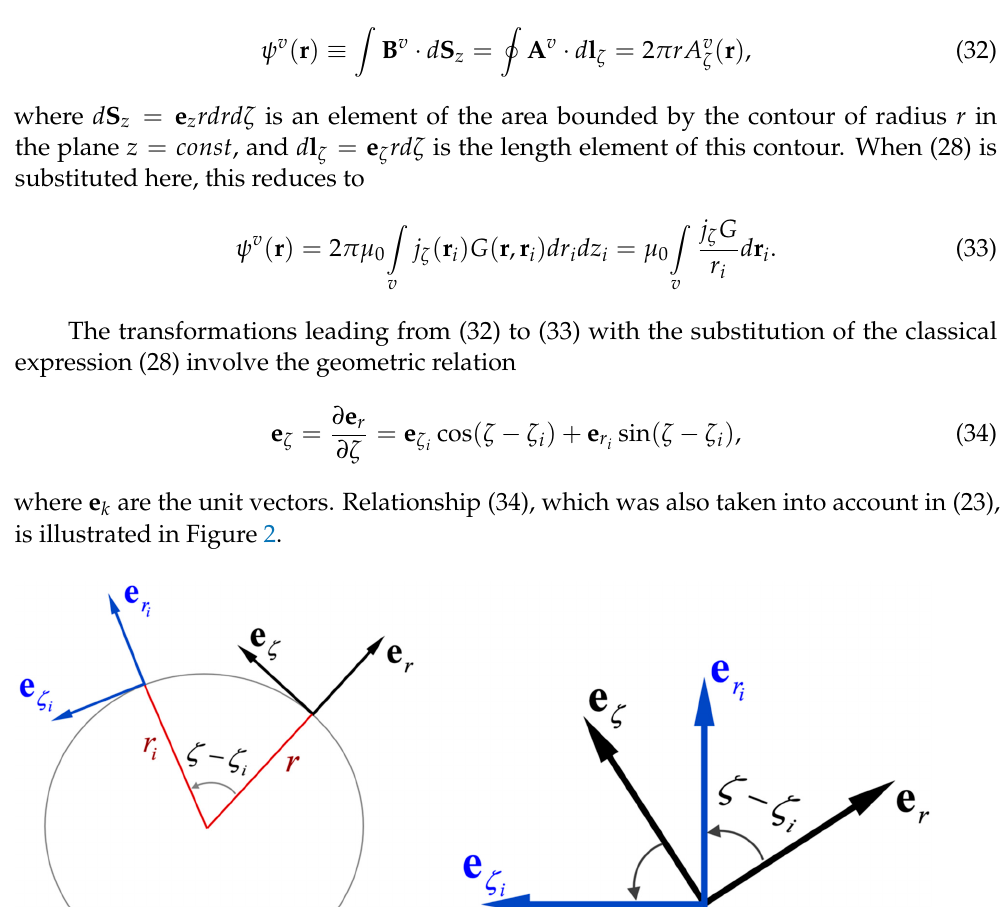
ζ ζ− is the angle